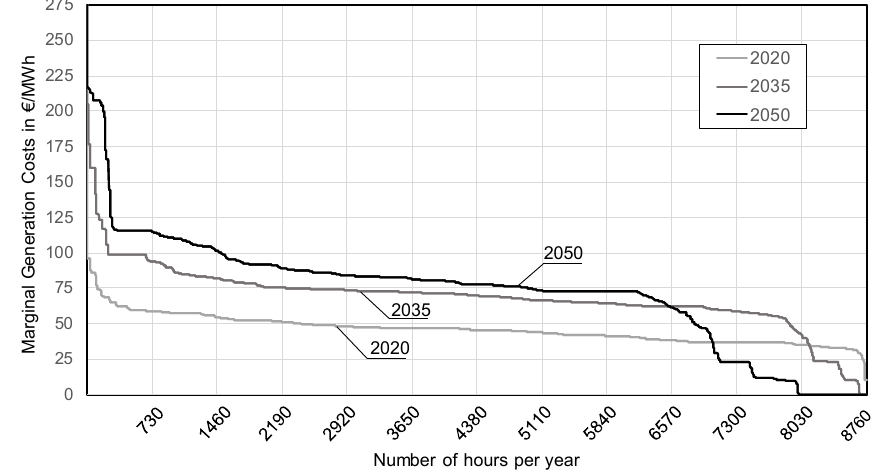
Figure 10. Year duration line: hourly marginal costs of electricity in € per MWh.